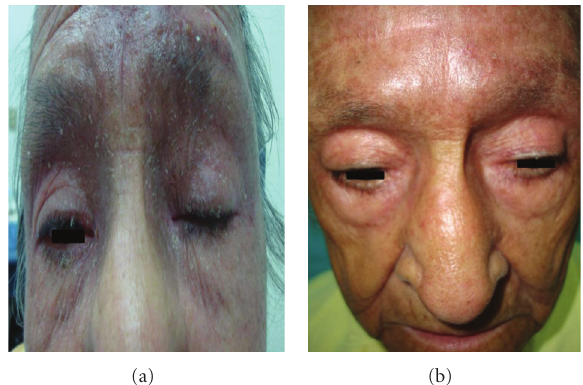
Figure 1: The status of the disease before starting HV is shown in Figure 1(a), and after treatment in Figure 1(b).